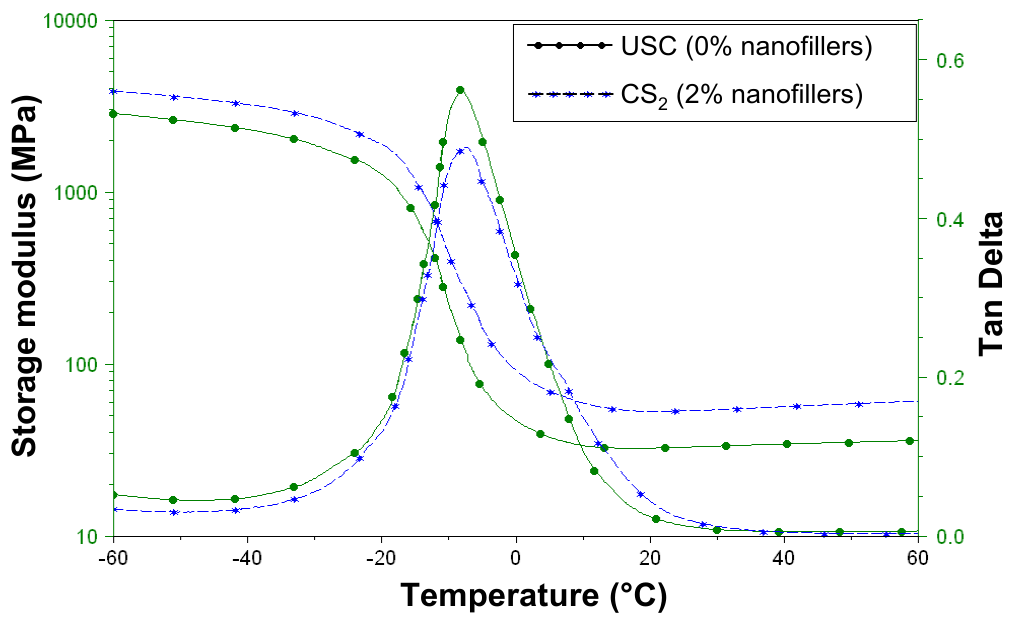
nanocomposite. 2